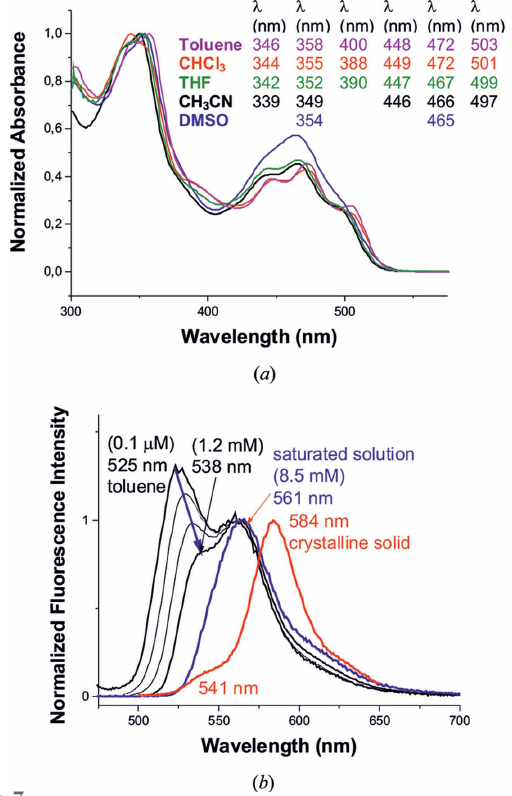
Figure 7 ( a ) Normalized absorption spectra of TAAP in toluene, CHCl 3 , THF, CH 3 CN and DMSO. ( b) Normalized fluorescence spectra (to the height of the band at 561 nm) at various concentrations of TAAP in toluene ( (cid:5) ex = 440 nm) and fluorescence spectrum of TAAP in the crystalline state (red line, (cid:5) ex = 350